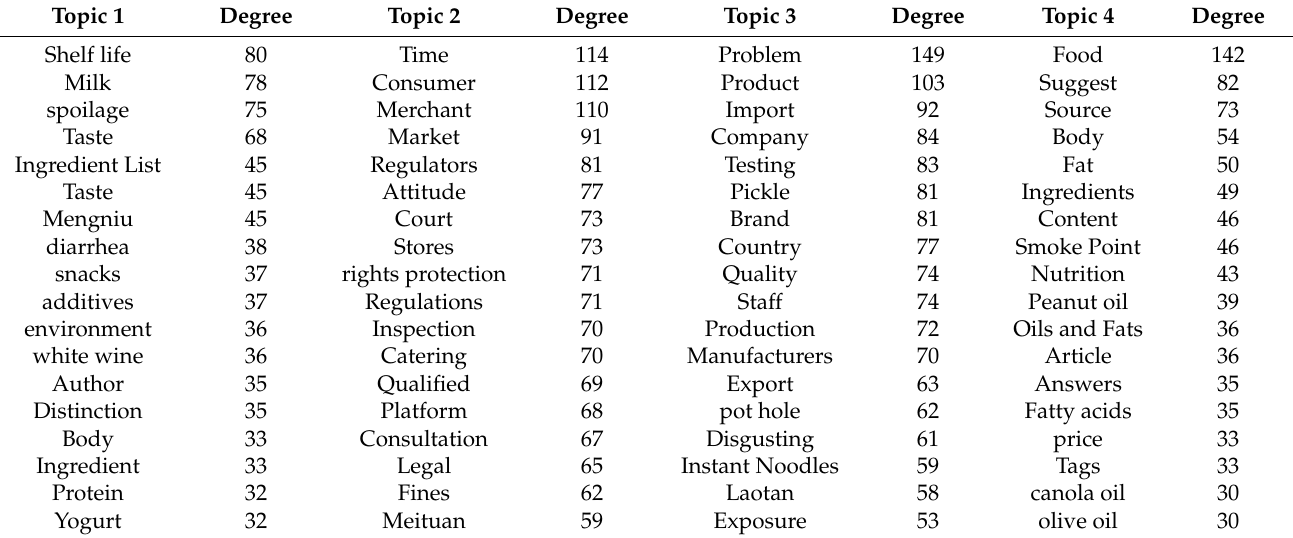
Table 12. Semantic community division of the topic of food safety.